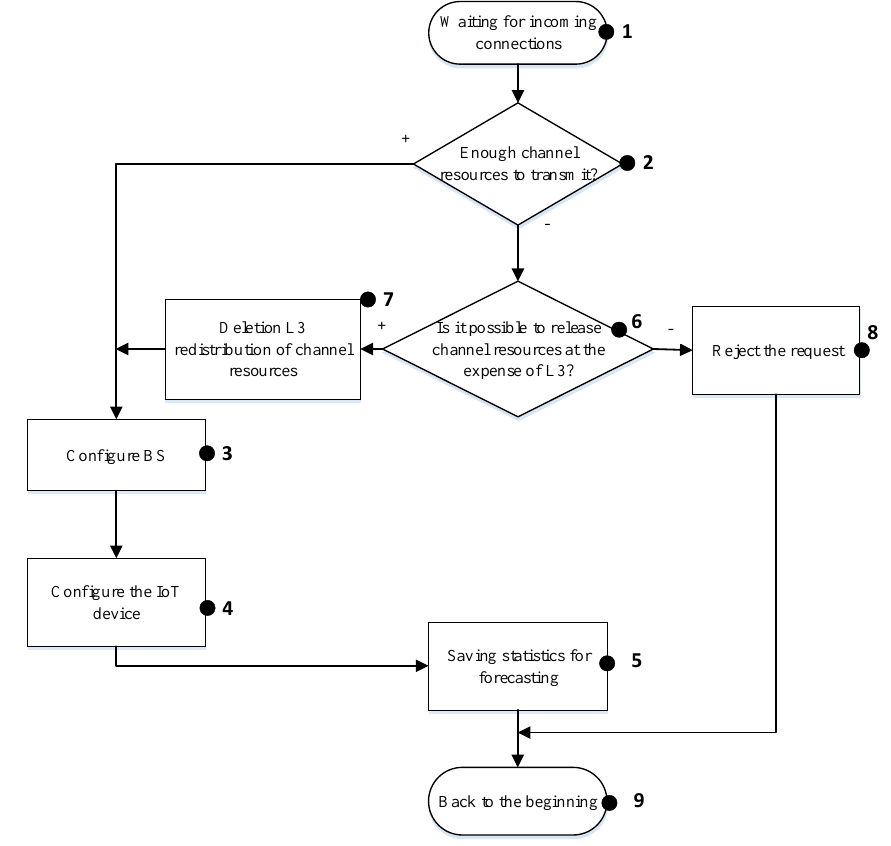
Figure 2. Algorithm for managing the “smart queue” for IoT class L1 .